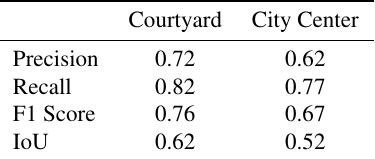
Table 1. Result of the quantitative evaluation of the method on the annotated Courtyard and City Center